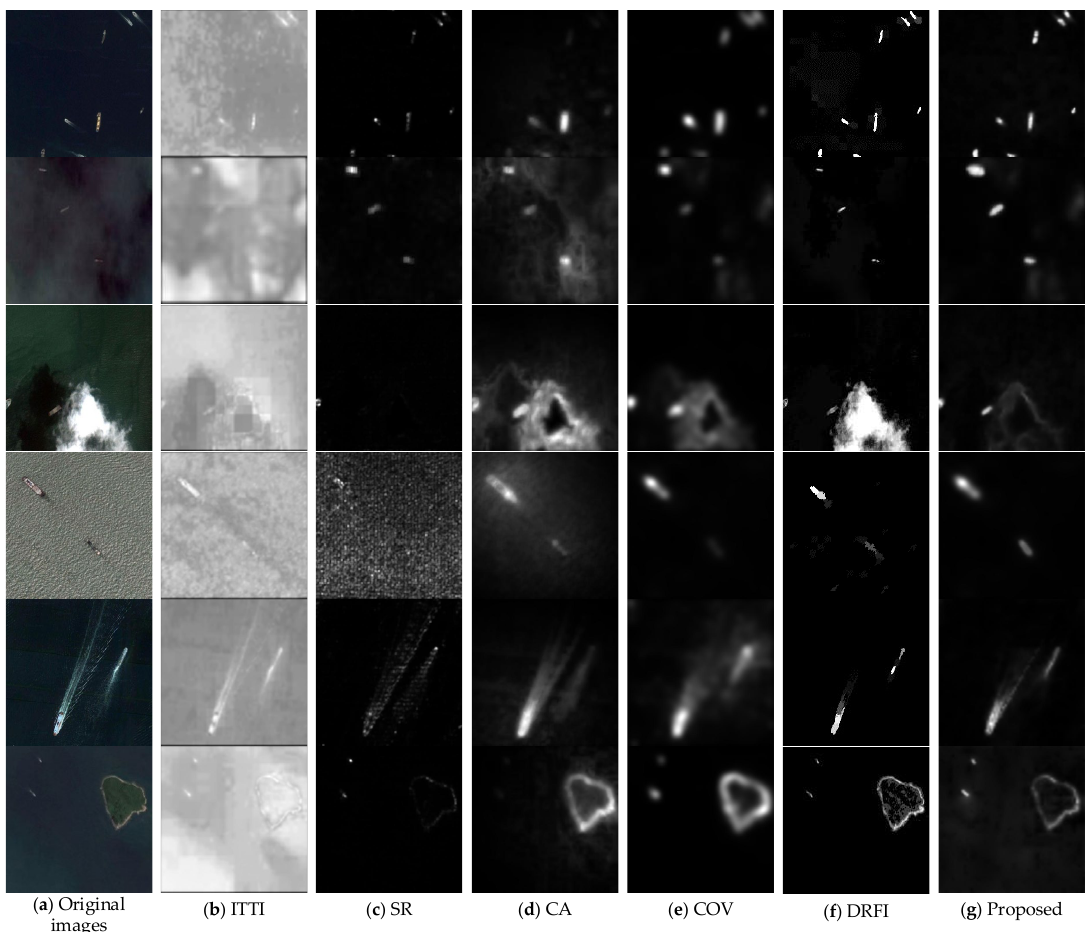
Figure 13. Qualitative subjective comparison among different saliency methods. ( a ) Typical senses of RSI at sea. ( b – g ) Saliency maps of ITTI, SR, CA, COV, DRFI and the proposed saliency model.